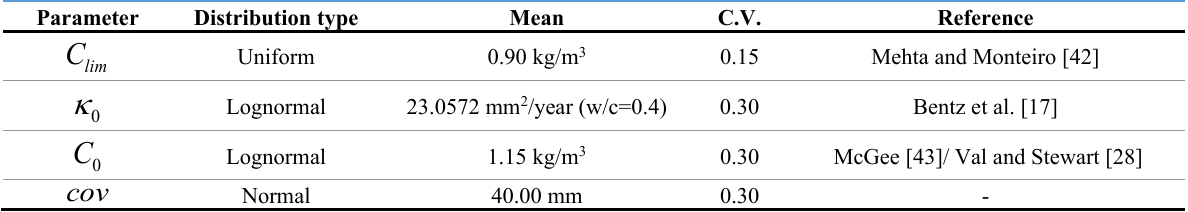
Table 1. Random variables